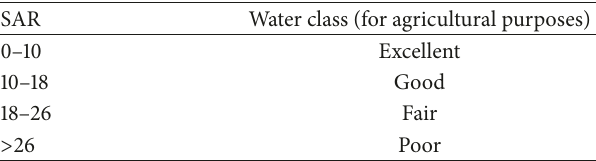
Table 6: Water classification for agricultural